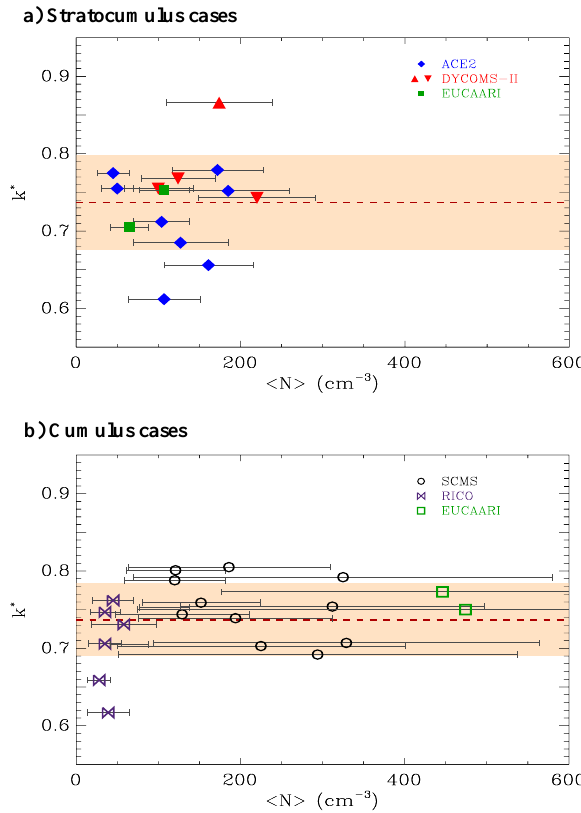
Fig. 7. Same as Fig. 6 for k ∗ values.